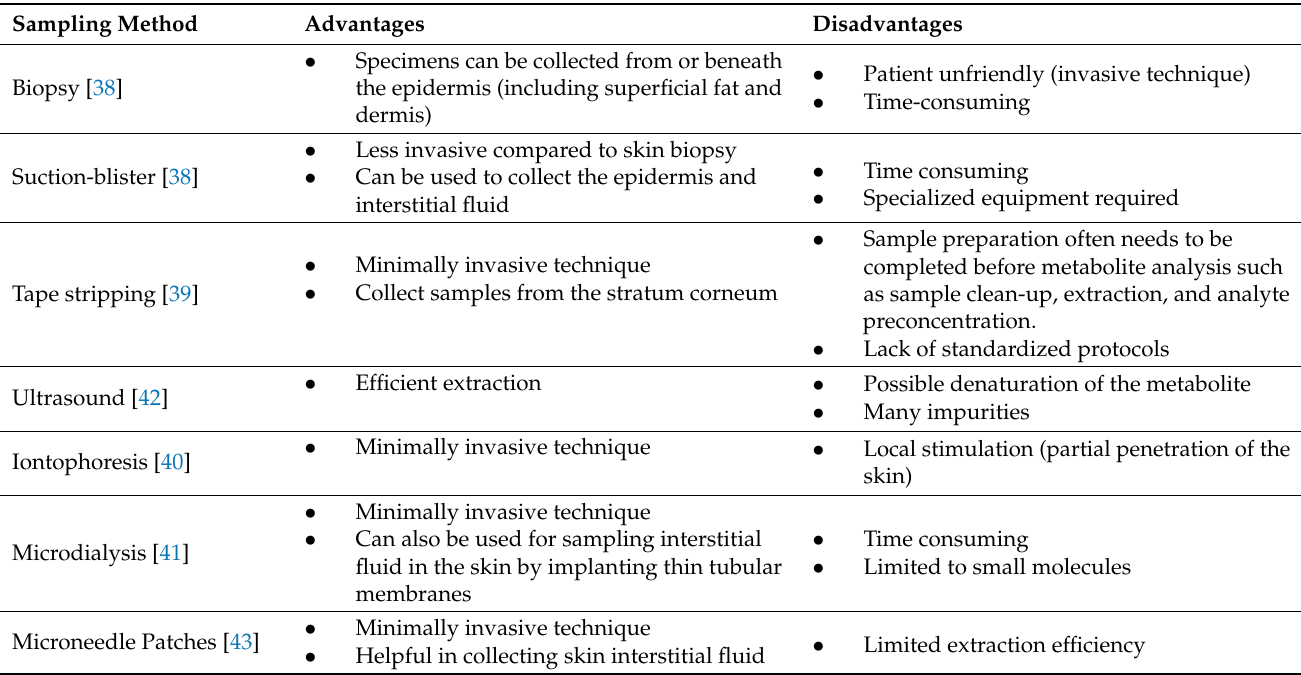
Table 1. Several sample collection methods for skin metabolomic